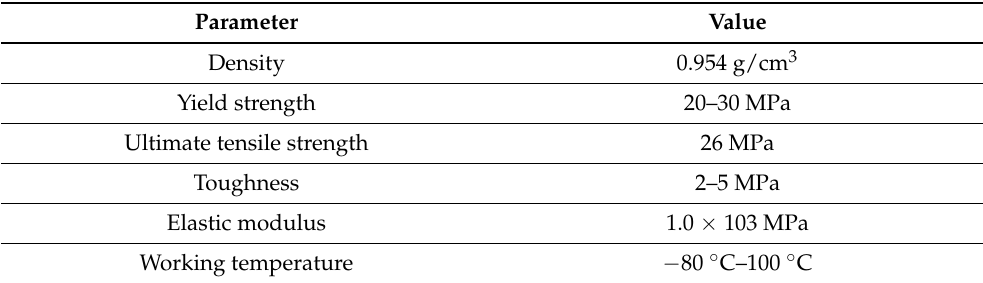
Table 3. Physical properties of high-density polyethylene